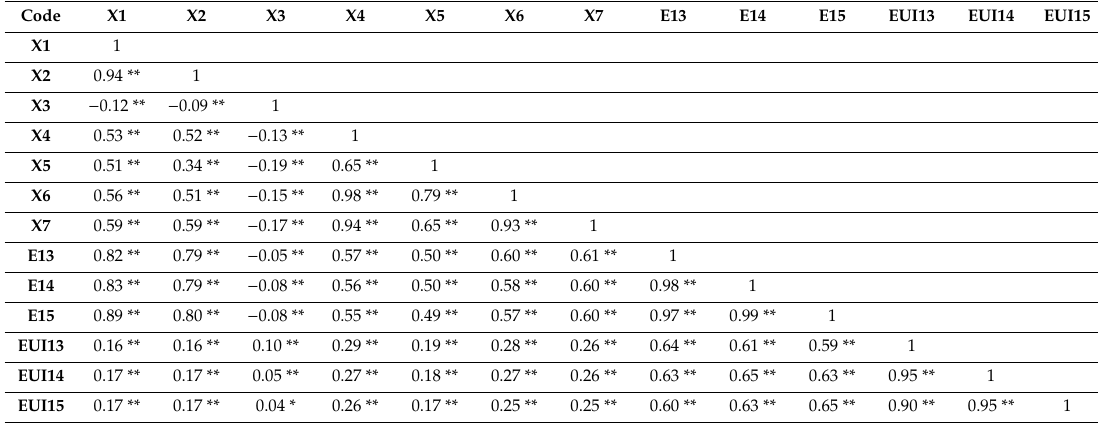
Table 3. Result of correlation analysis between